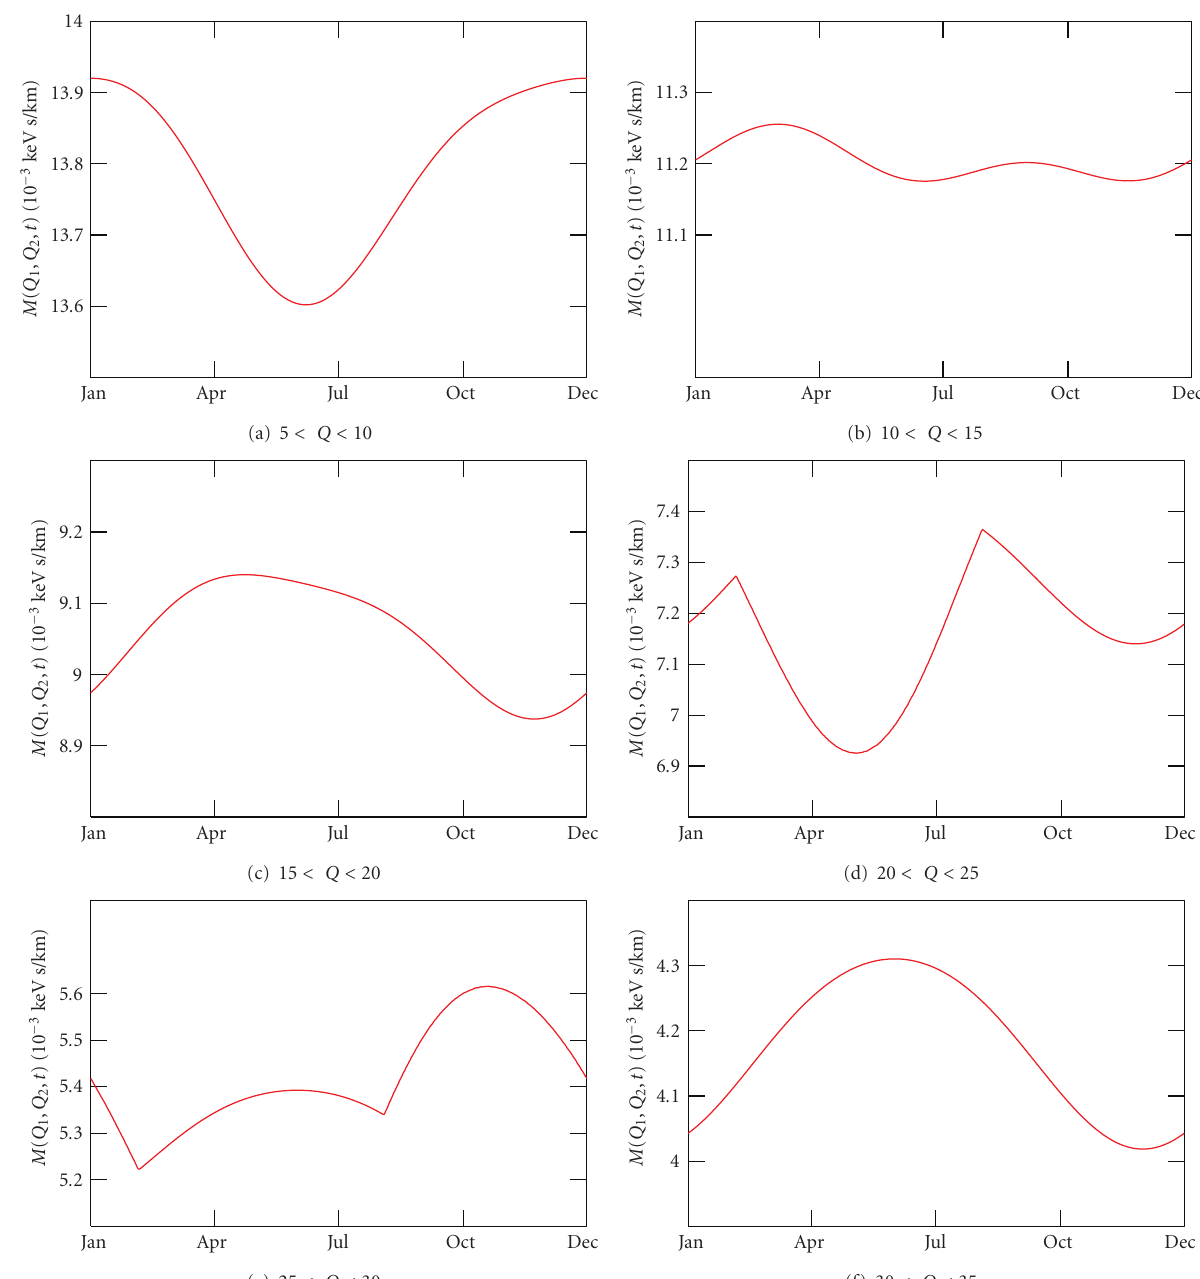
Figure 6: Annual modulation in M(Q 1 ,Q 2 ,t) for the caustic flow (a). Q is in keV. Case ξ = 0 .